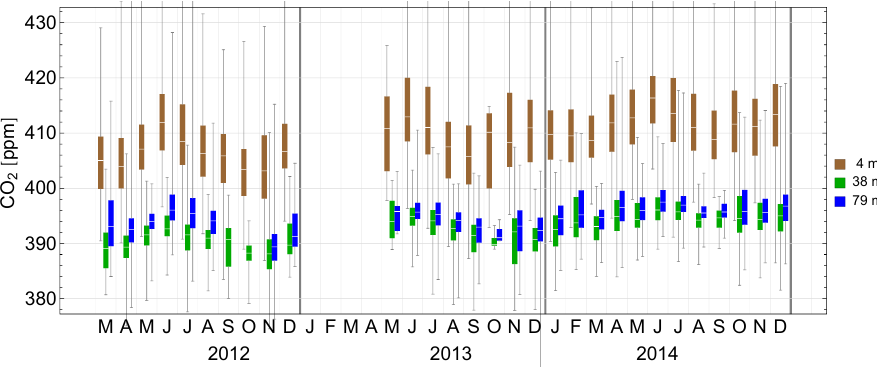
Figure 19. Statistics of monthly daytime (17:00–20:00UT) 30min measurements of CO 2 at the 80m walk-up tower. Shown are whisker plots indicating min/max and quartiles of the monthly measurements. The white line in the box indicates the median. Brown: 4m level, green: 38m level, blue: 79m